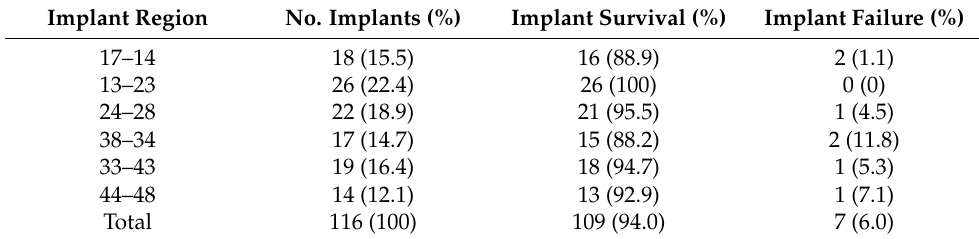
Table 5. Implant positions and respective survival/failure rates.